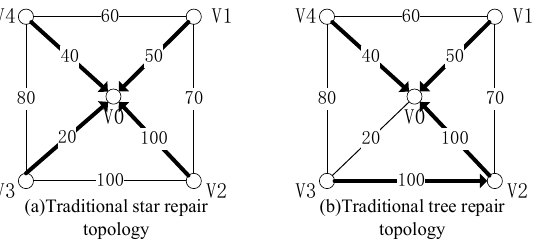
Figure 1. Traditional star repair topology and tree repair topology (unit Mbps).